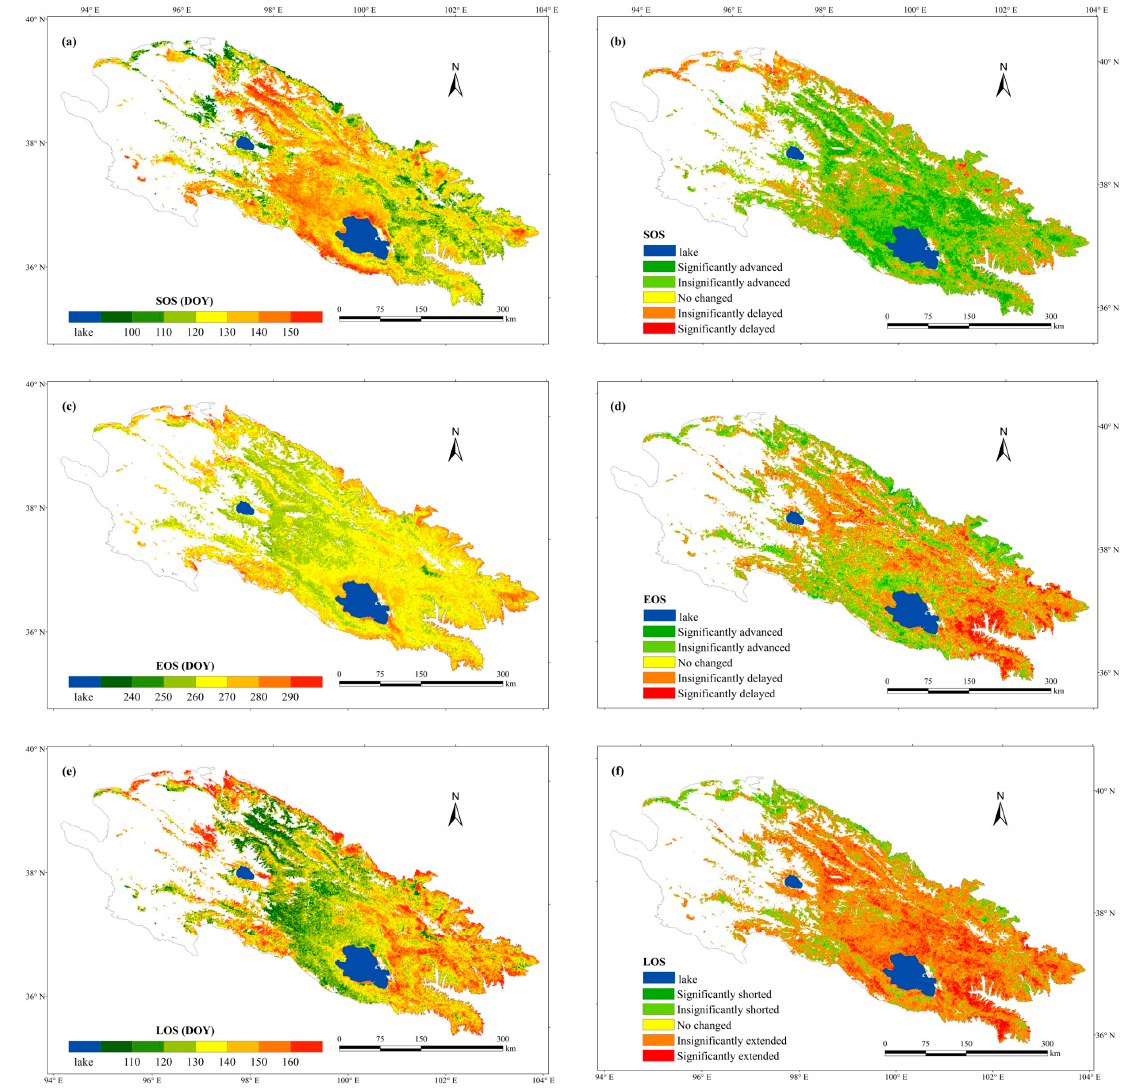
Figure 4. Spatial distribution and the change trend of vegetation phenology parameters. The left side represents the spatial pattern of the average value of the SOS ( a ), EOS ( c ), and LOS ( e ) from 2001 to 2020. The right side represents the spatial distribution of the change trend of the SOS ( b ), EOS ( d ), and LOS ( f ) from 2001 to 2020. The trends are considered significant for pixels according to the MK test ( p < 0.05). Table 1. The percentage of different trends of vegetation parameters based on MK analysis across the QLMs.